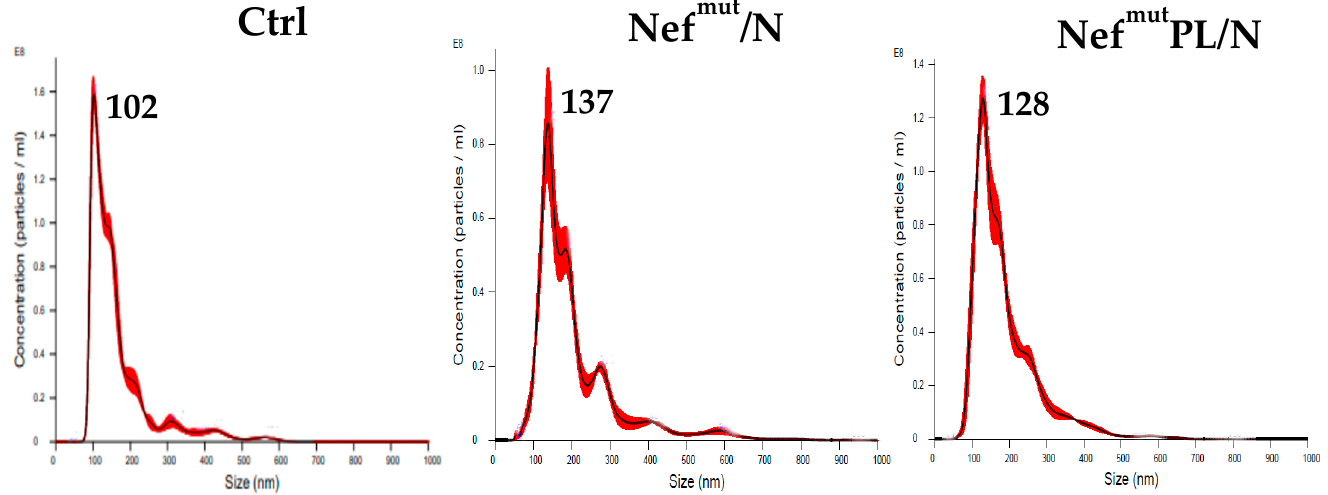
Figure 3. NTA analysis of EVs from transfected HEK 293T cells. EVs from cells transfected with either Nef mut /N, Nef mut PL/N or, as control, pVAX1 (Ctrl) were isolated by differential centrifugation, and resuspended in the same volumes of buffer. Preparations were then diluted 20 times and analyzed 5 times with a Nanosight NS300 device. Size distribution and average concentration of EVs are reported as calculated. The results are representative of two independent experiments.